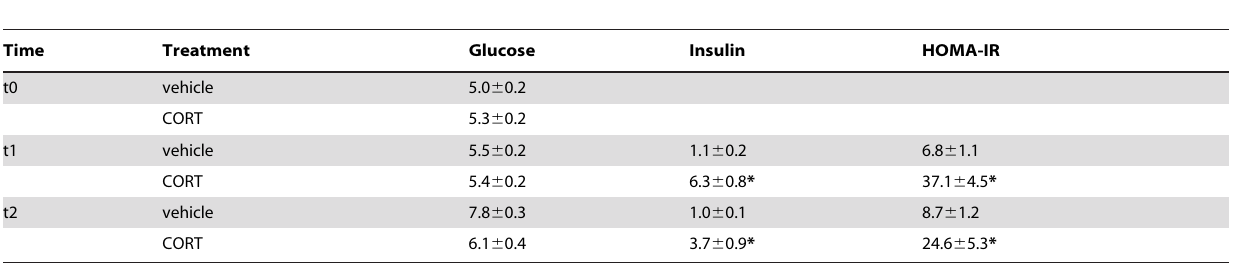
Table 2. Mean ( 6 S.E.M.) fasting blood glucose (mmol/l), plasma insulin (ng/ml) values and HOMA-IR index at baseline (t0), after 4 weeks (t1) and after 12 weeks treatment (t2).